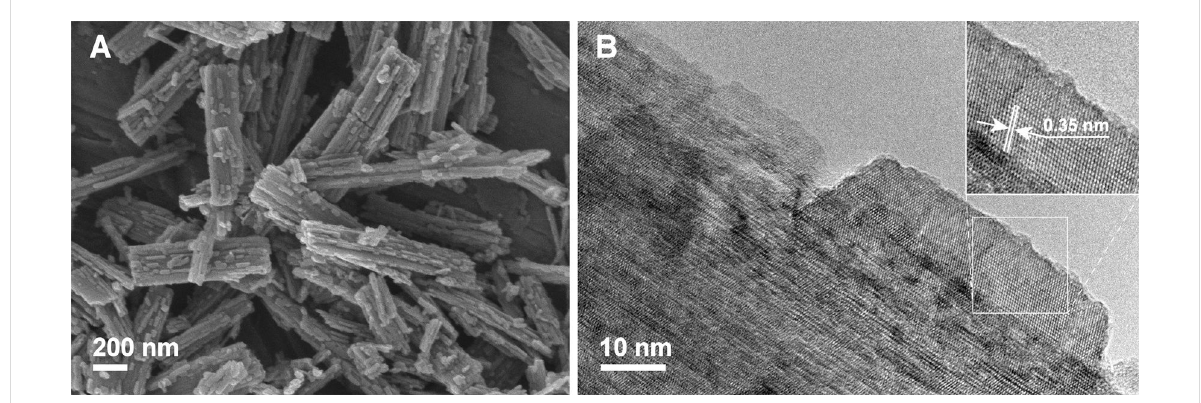
Figure 5: A) SEM and B) TEM images of TiO 2 nanoribbons derived from hydrogen titanate nanoribbons after treatment in a microwave reactor at 200 °C for 2 h in deionized water ( MW-W ). The inset to B: the measured interplanar spacing corresponds to a d spacing of 0.35 nm and is consistent with the (101) planes of anatase.